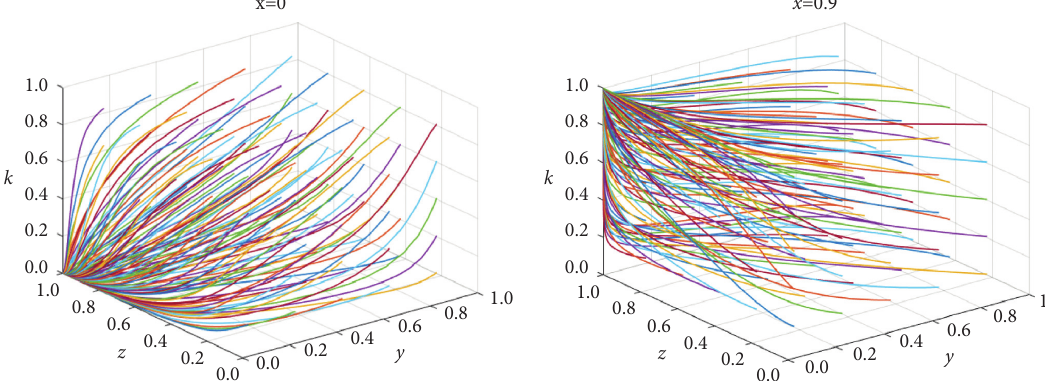
Figure 8: The impact of government support mechanisms on the evolution of various parties’